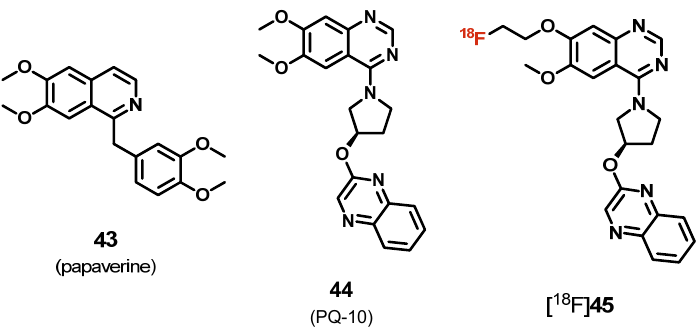
Figure 8. Molecular structures of 43 , a related PDE10A inhibitor and the 18 F-labeled derivative thereof for PET.